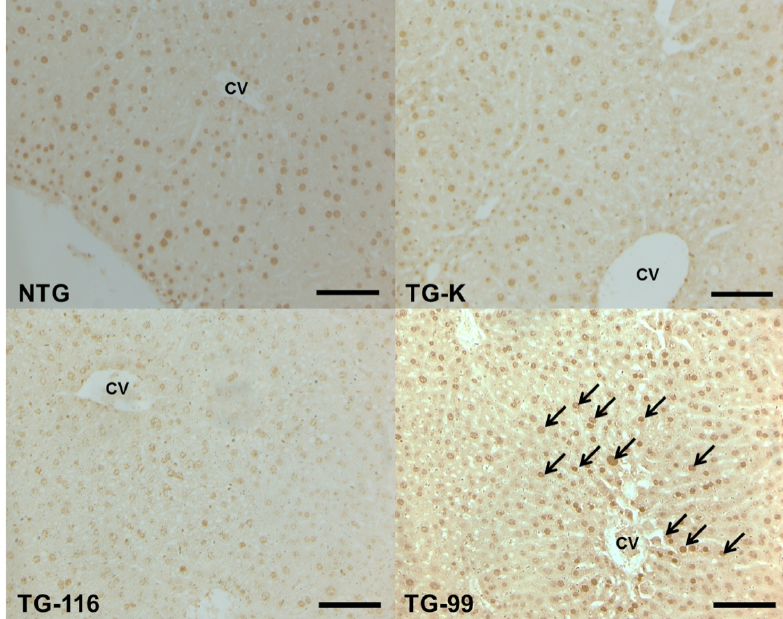
Figure 7. Immunohistochemistry staining of p-SMAD2/3. Arrows indicate p-SMAD2/3 positive cells. Scale bar = 100 μ m. CV, central vein.